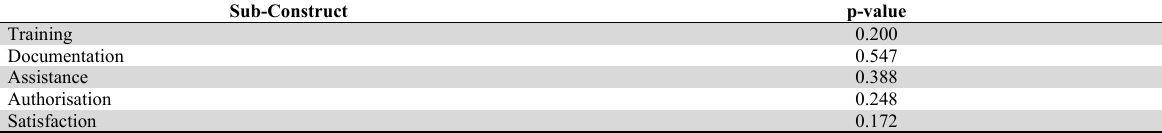
Chi-square test for early vs. late